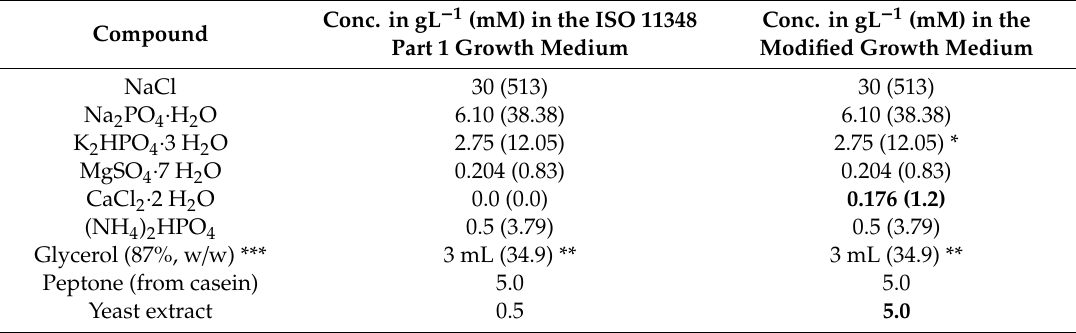
Table 1. Composition of the original and modified growth medium. Differences to the original medium are indicated in bold.